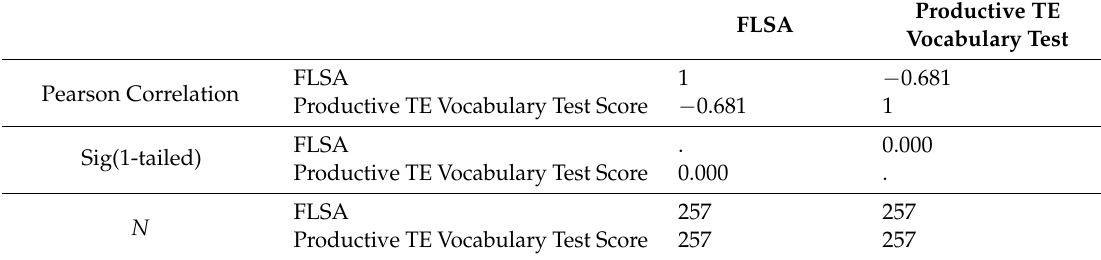
Table 6. Correlations.